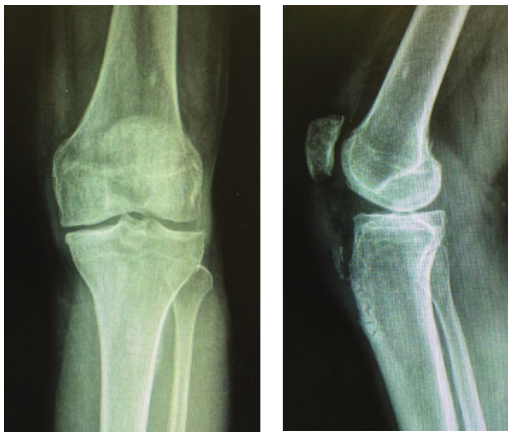
Figure 3: Knee X-ray at 5-month